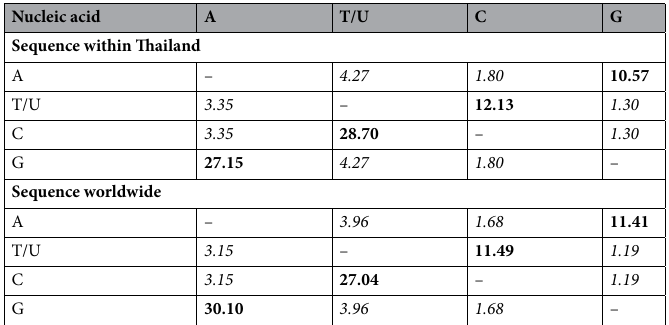
Table 4. The nucleic acid substitution rate in L. sabrazesi cytb sequences as detected in chickens in Thailand and other countries. Each entry is the probability of substitution from one base (row) to another base (column). Rates of different transitional substitutions are shown in bold and those of transversional substitutions are shown in italics. The maximum Log likelihood for this computation was − 554.346 and − 588.782 for the sequences within Thailand and worldwide,